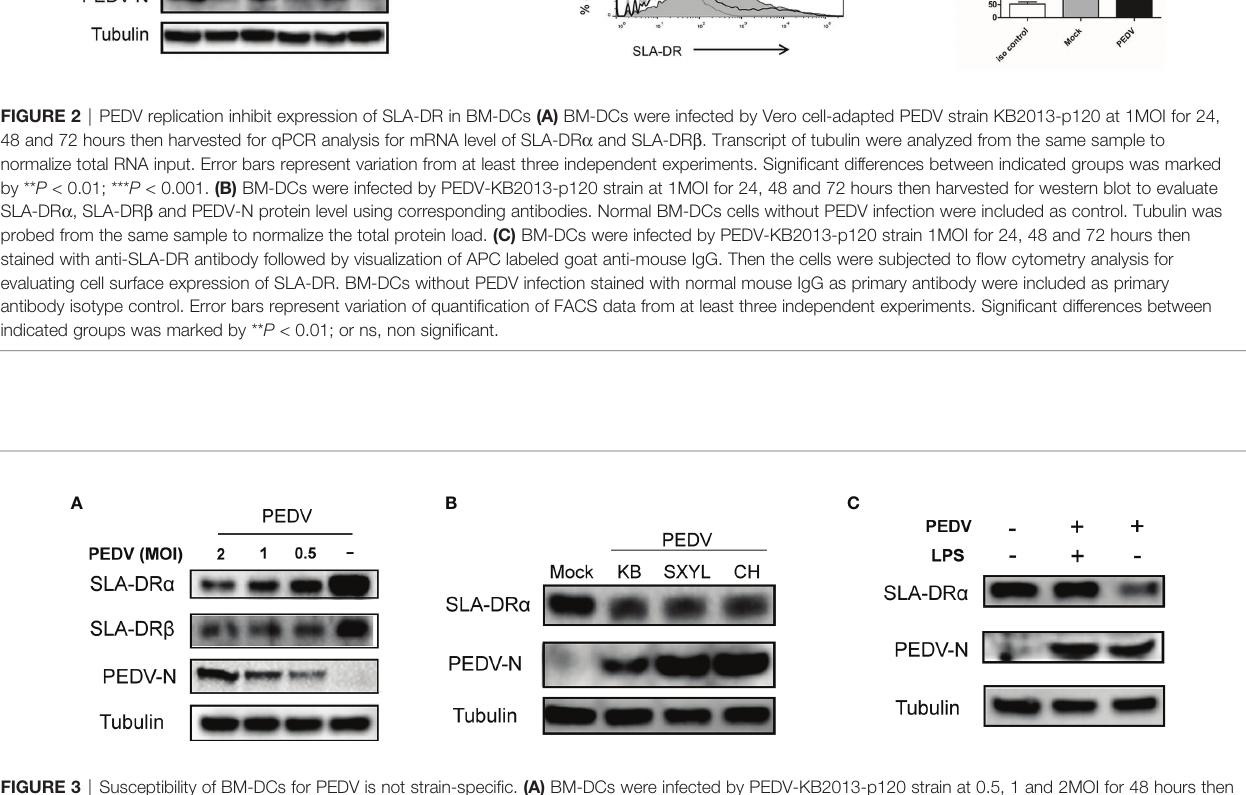
FIGURE 3 | Susceptibility of BM-DCs for PEDV is not strain-speci fi c. (A) BM-DCs were infected by PEDV-KB2013-p120 strain at 0.5, 1 and 2MOI for 48 hours then harvested for western blot to evaluate SLA-DR a , SLA-DR b and PEDV-N protein. Normal BM-DCs cells without PEDV infection were included as control. Tubulin was probed from the same sample to normalize the total protein load. (B) BM-DCs were infected by Vero cell-adapted PEDV strain KB2013-p120, virulent PEDV strain CH/hubei/2016 (GenBank accession number: KY496315.1), and a fi eld PEDV isolate SXYL-21 for 48 hours. Next, cells were harvested for western blot using mice serum raised against recombinant PEDV-N protein and anti-SLA-DR a Mab. Normal BM-DCs cells without PEDV infection were included as control. Tubulin was probed from the same sample to normalize the total protein load. (C) BM-DCs were infected by PEDV-KB2013-p120 strain at 1 MOI for 24 hours then 10 m g LPS was added to the PEDV infected BM-DCs to stimulate the cells for another 24 hours. Next, all cells were harvested for western blot to evaluate SLA-DR a , SLA-DR b and PEDV-N protein. PEDV infected BM-DCs without LPS stimulation and normal BM-DCs cells were included as controls. Tubulin was probed from the same sample to normalize the total protein